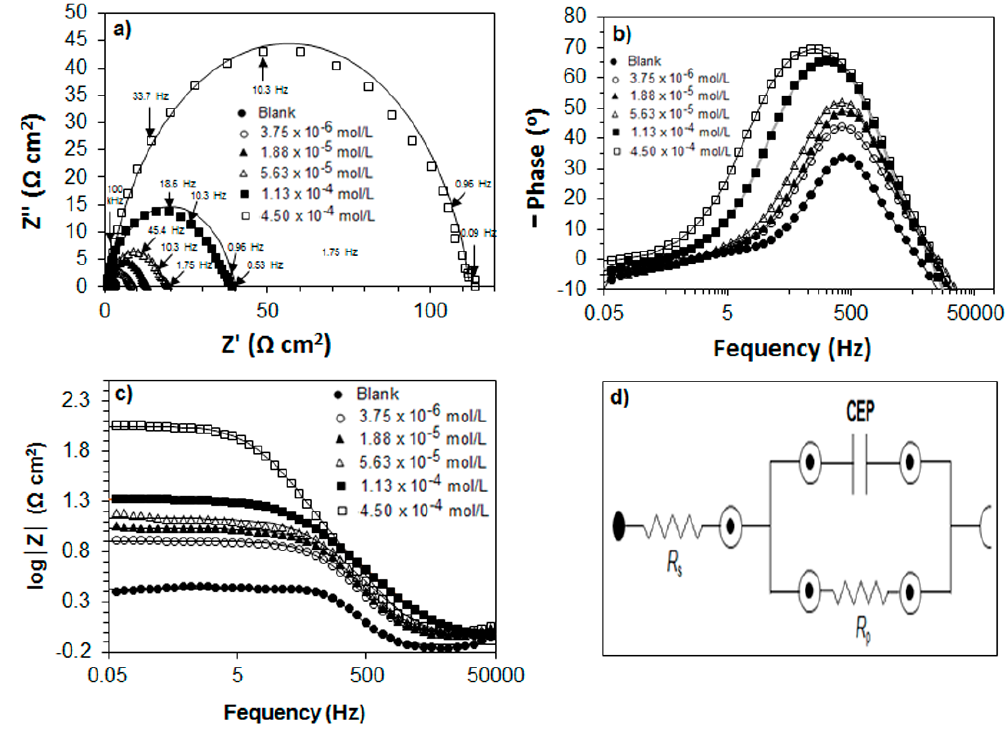
Figure 7. ( a ) Nyquist plots, ( b ) Bode phase angle plots, ( c ) Bode plots of mild steel at 333 K in 1 M HCl containing different concentrations of corrosion inhibitors 7, and ( d ) the equivalent circuit model used to fit the electrochemical impedance spectroscopy (EIS) data. Th solid line in the Nyquist plot is fitted to the equivalent circuit; various symbols represent experimental data and solid lines represent fitted data.